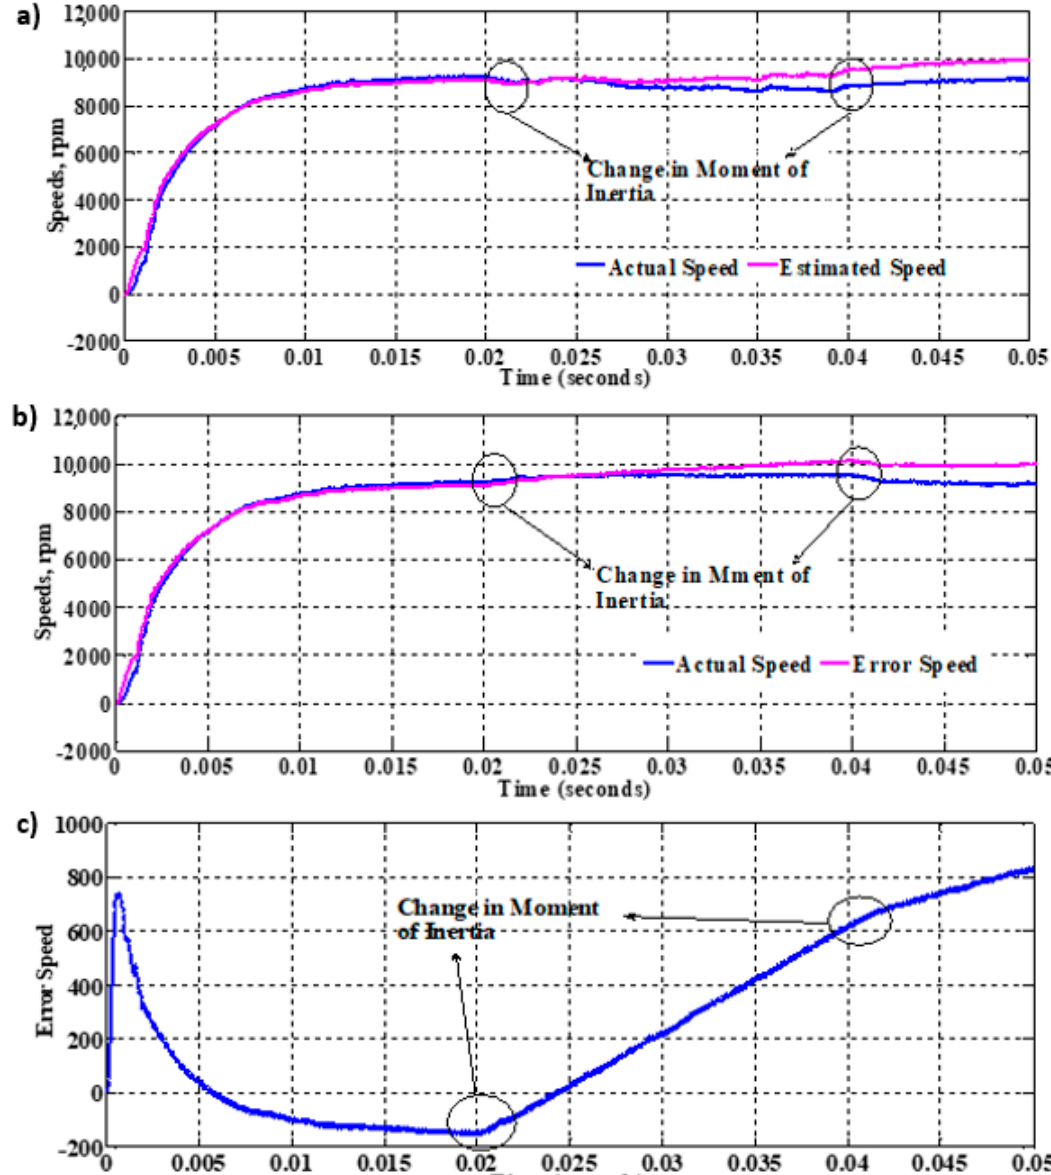
Figure 20. ( a ) Estimated and actual speeds when there are increments in the moment of inertia, ( b ) Estimated and actual speeds when there are decrements of the moment of inertia, and ( c ) Speed tracking error for change of the moment of